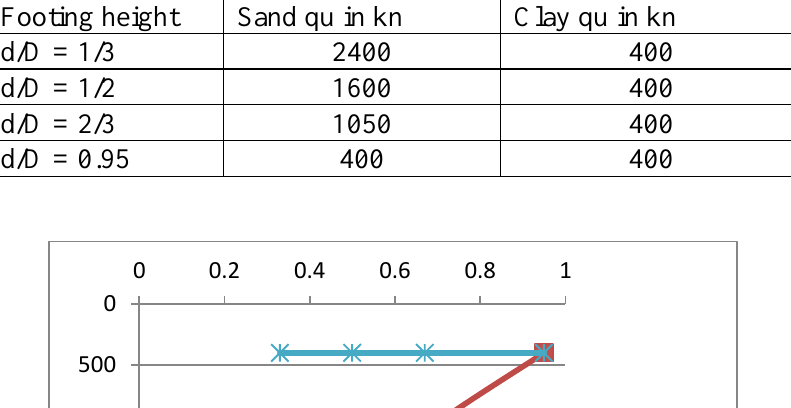
Table 4. Bearing Capacity affection of ring Footing (d/D) ratio. Footing height